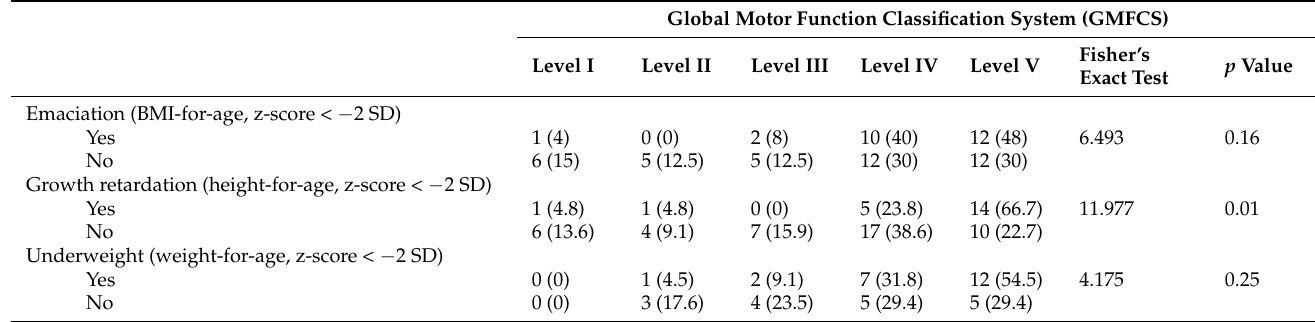
Table 4. Nutritional indices in relation to patients’ gross motor ability levels.